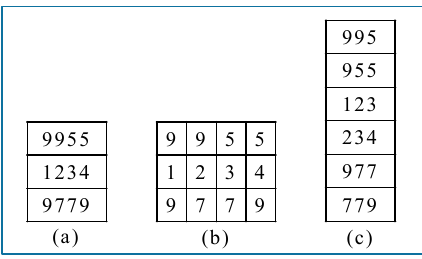
Figure 17. Check lists using the three types of ground truth data: ( a ) Four-digit list, ( b ) one-digit list, and ( c ) three-digit list.